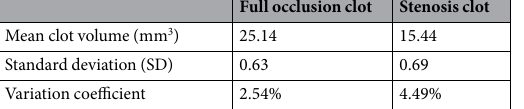
Table 2. Intra-operator repeatability of the 3D clot volume measurement.